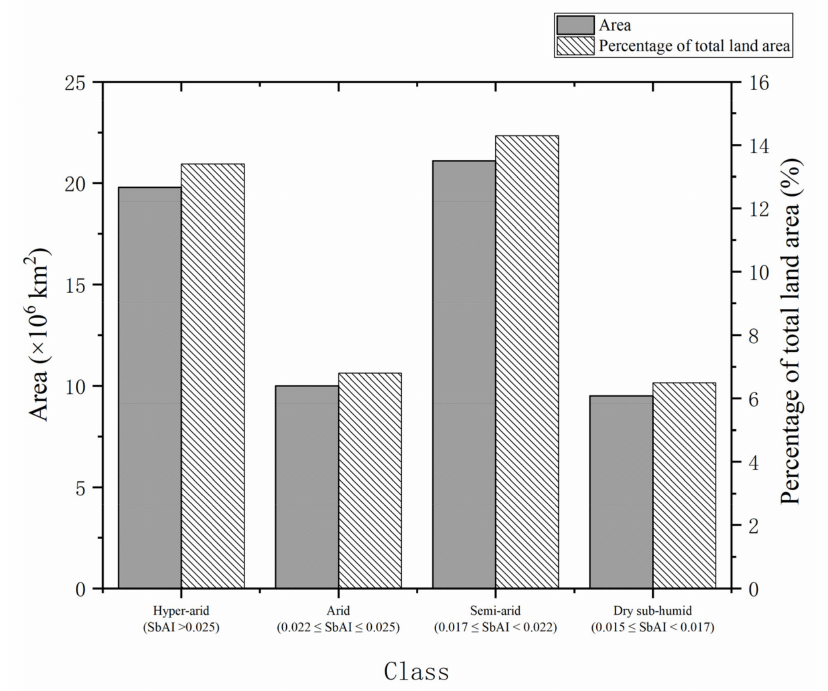
Figure 1. Schematic diagram of arid areas worldwide and their percentage of total land area in 2017 based on the Satellite Drought Index (SbAI) [3].